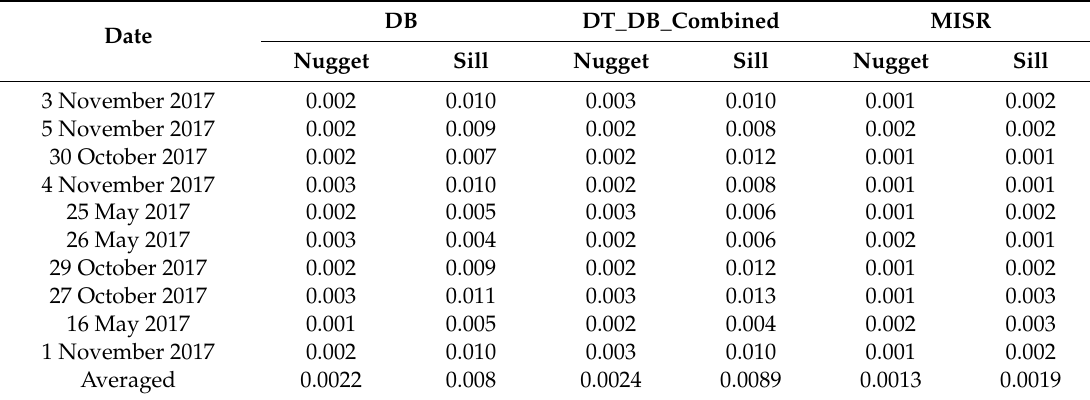
Table 1. Parameters of fitted spherical models for randomly chosen 10 days’ AOD products with better spatial coverage.